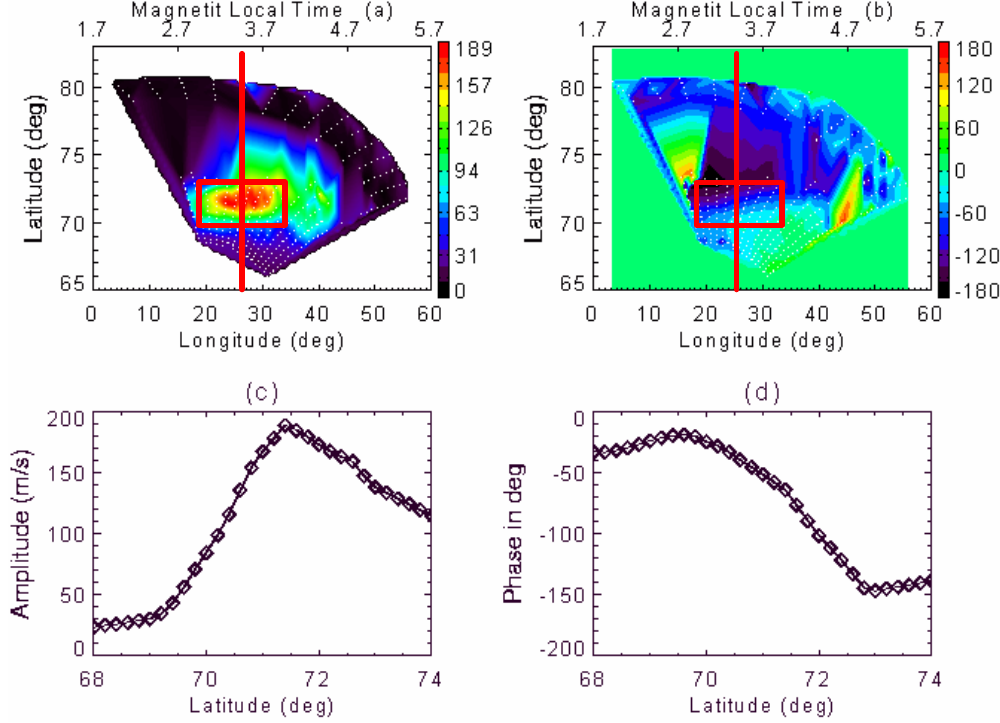
Fig. 4. The snapshot of the amplitude (a) and phase (b) of the 1.9mHz frequency component from Goose Bay data from beams 1 to 15 (left to right) taken at 7.3UT. The white dots represent the field of view of the radar. The red rectangles in (a) show an enhancement in amplitude near the resonant latitude of 71.3 ◦ while the rectangle in (b) shows the 180 o phase change. Panels (c) and (d) show the amplitude and phase spectra of this component at 7.3UT along 25 ◦ longitude. These figures further emphasize the FLR characteristics obtained by making a cut through plots (a) and (b) illustrated by red lines.